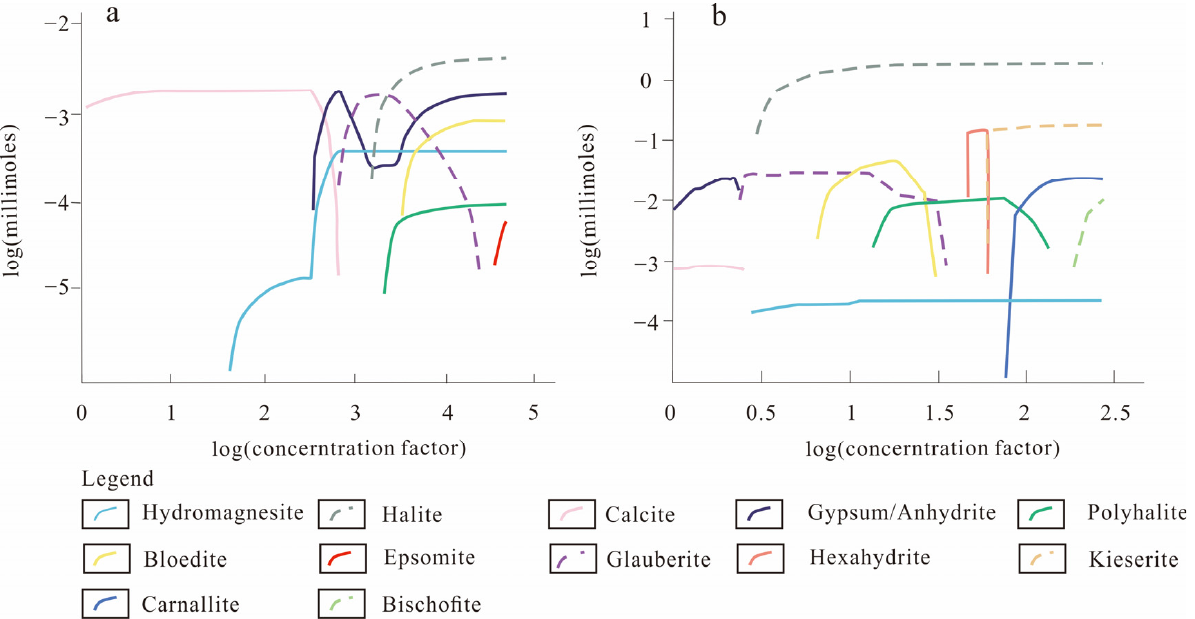
Figure 8. Modeling of Tarim water and brine evolution pathway in the Lop Nor Basin by EQL/EVP program in closed system conditions at 25 °C and Ρ co 2 of 10 − 3.4 . ( a ) Simulated evolution of Tarim river water; ( b ) simulated evolution of brines at the edge of the Lop Nor basin [48].